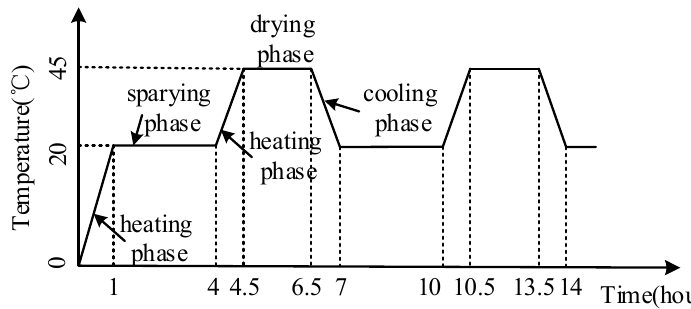
Figure 3. Corrosion cycle system schematic diagram.